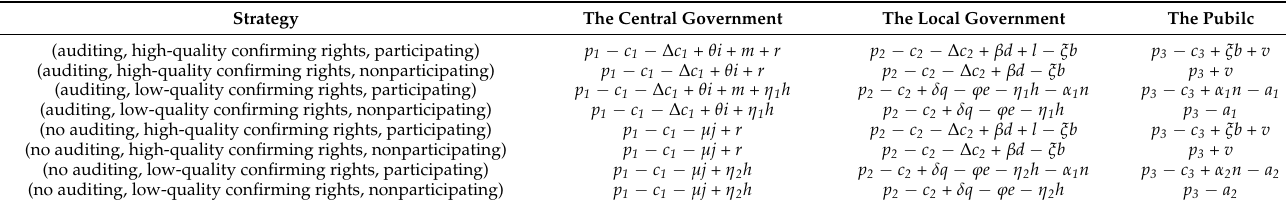
Table 2. Payoff matrix of tripartite evolutionary